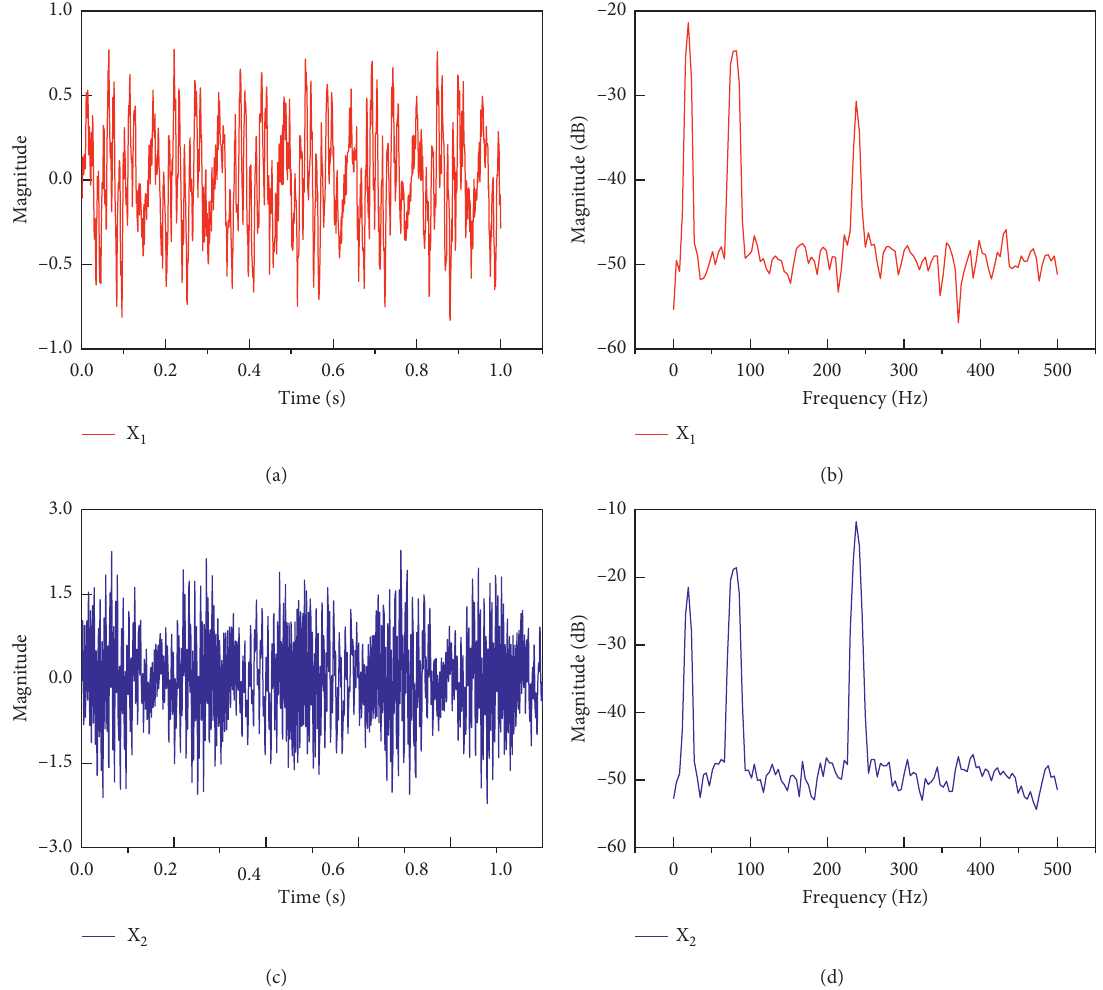
Figure 10: The mixed signal X 1 and X 2 in time domain and spectrum domain. (a) Mixed signal X 1. (b) X 1 power spectrum. (c) Mixed signal X 2. (d) X 2 power